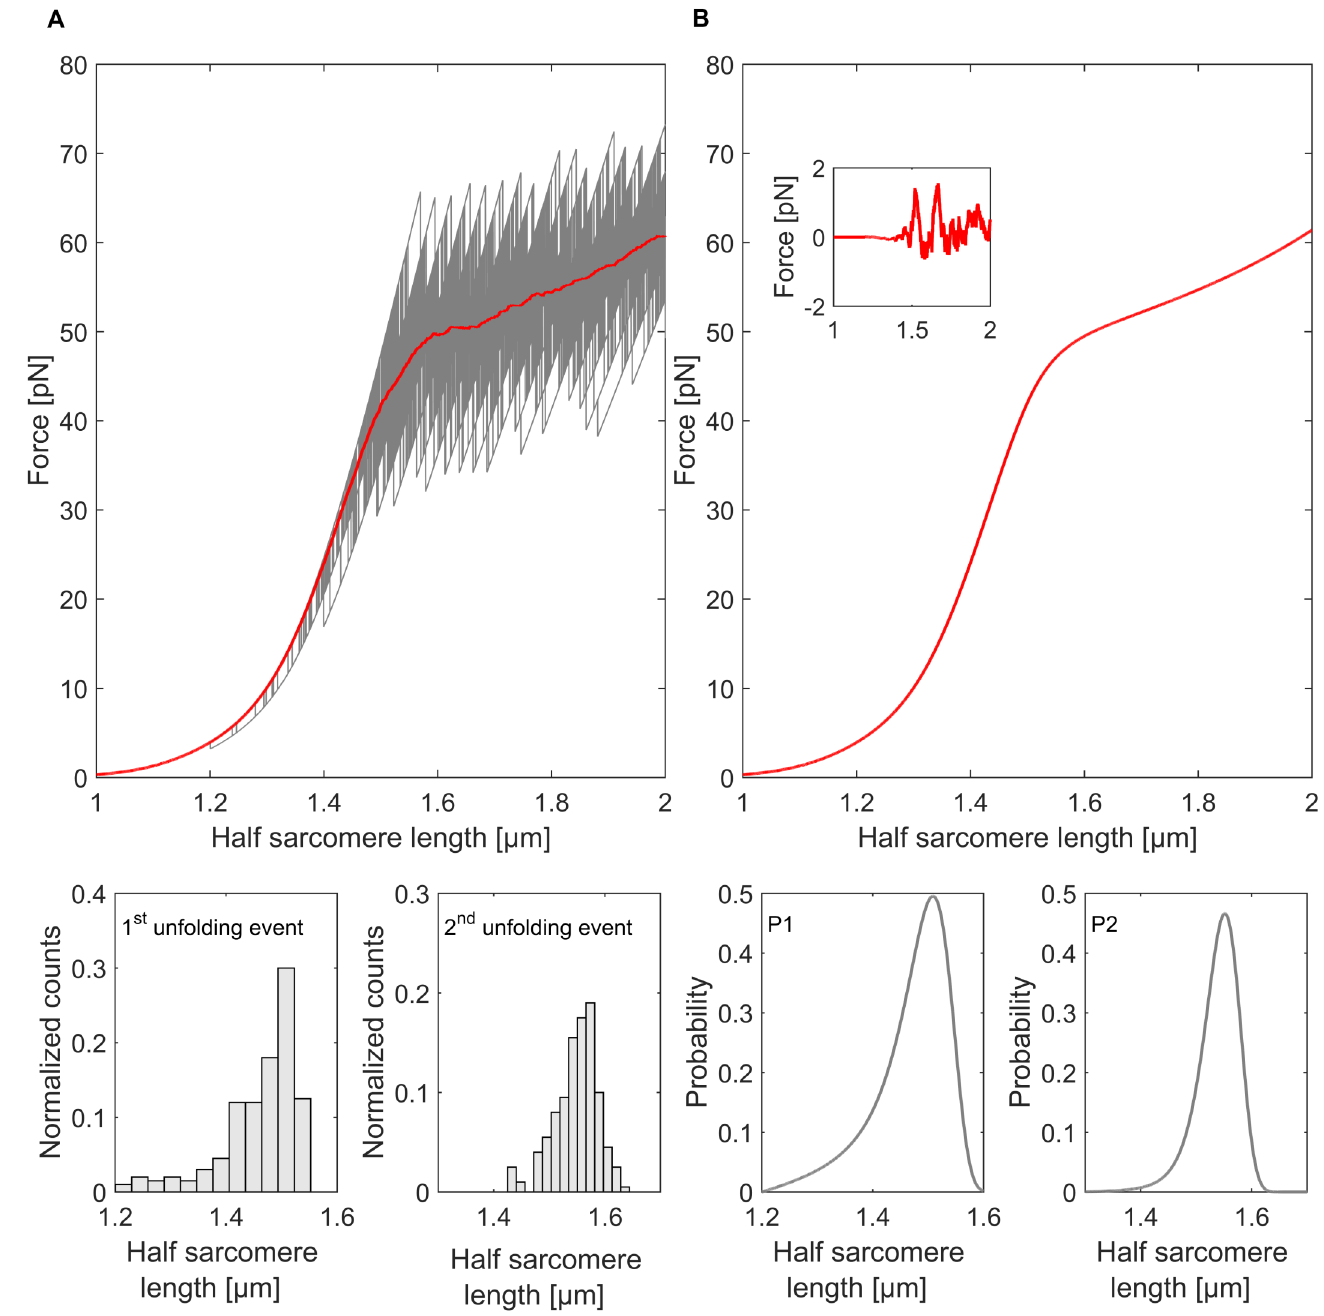
Fig 4. Comparison between the two methods. A Force-elongation curves of the Monte Carlo simulation. The red line indicates the mean value of force at a given half sarcomere length. The resulting curve is similar to the exact solution B . The small insert shows the difference between the two methods. The error of the Monte Carlo approximation rises with the first unfolding events but stays well within a 2pN range. The probability function and the normalized histograms (bin size based on the Freedman-Diaconis rule [44]) show similarities in shape.